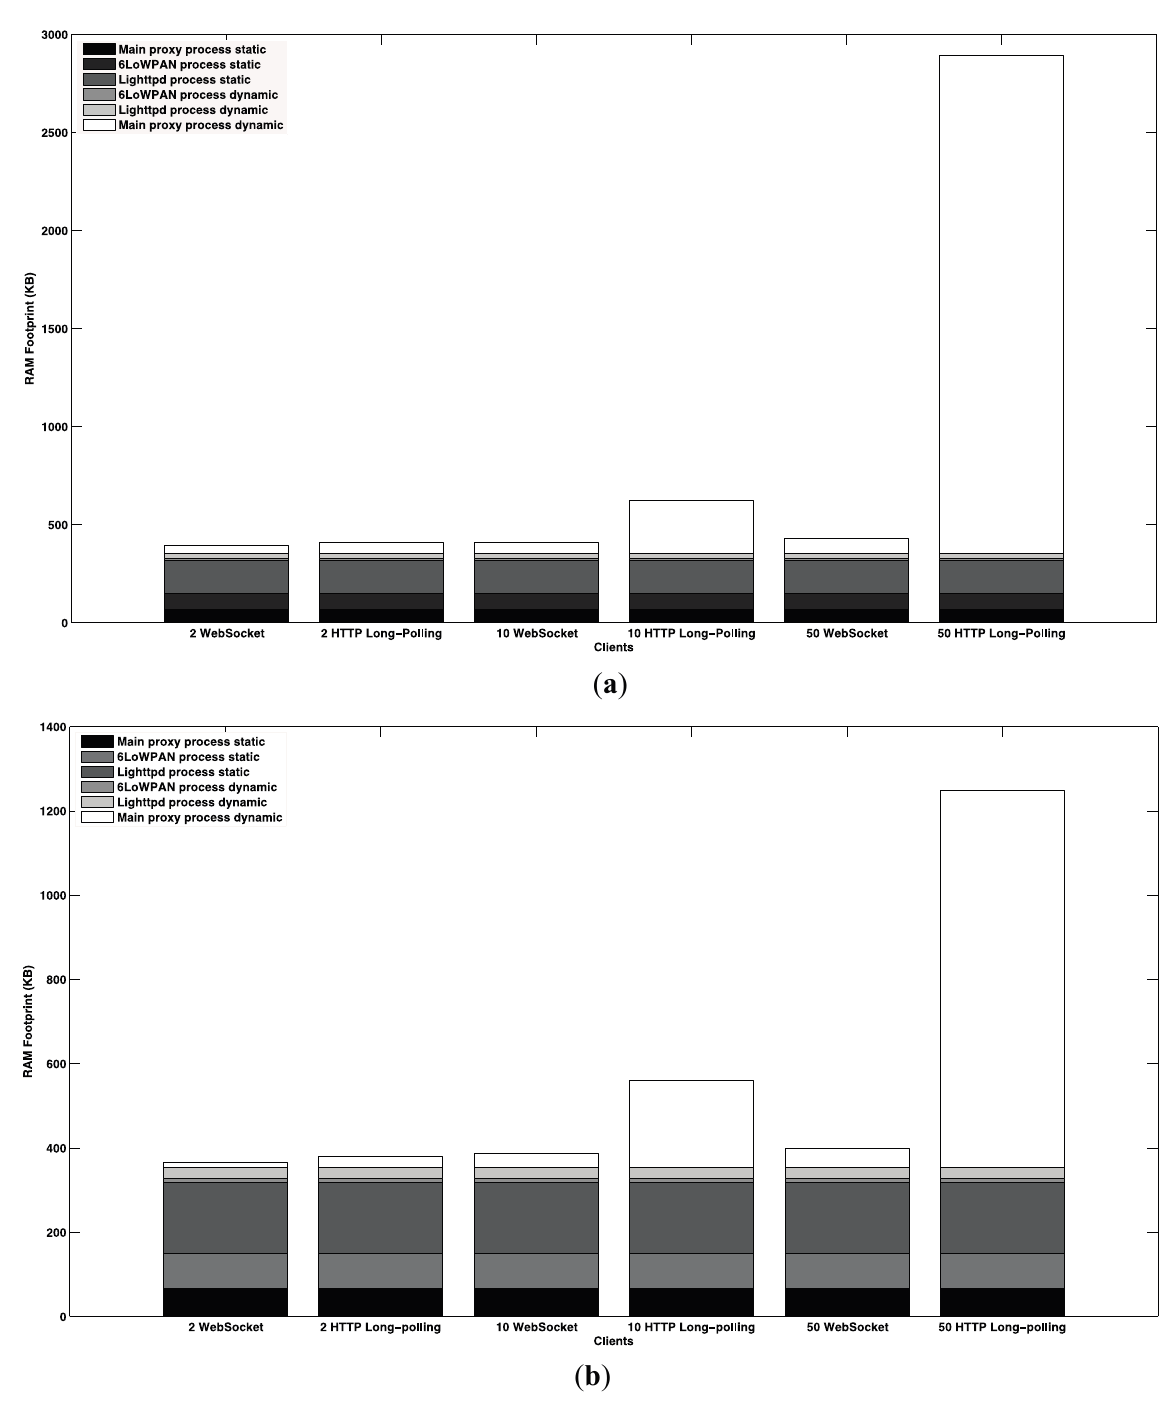
Figure 13. RAM footprint of the CoAP proxy. It has a low memory footprint when using WebSocket. The FastCGI protocol used in HTTP long-polling requires more complexity that results in a growth of the memory consumption. ( a ) RAM footprint of CoAP proxy in short-lived communications; ( b ) RAM footprint of the CoAP proxy in long-lived